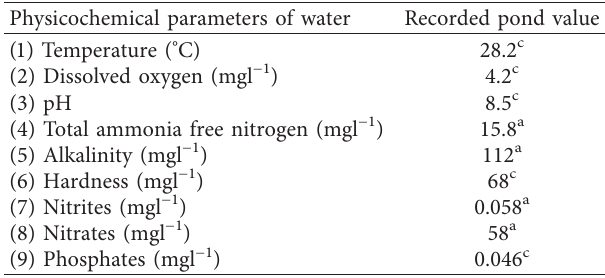
Table 1: Mean values of physicochemical parameters of pond